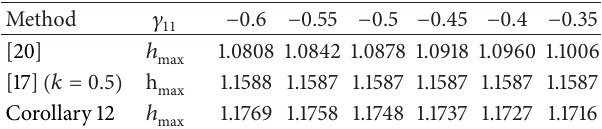
Table 4: The maximum allowable upper bound for different 𝛾 11 and time-invariant delay.